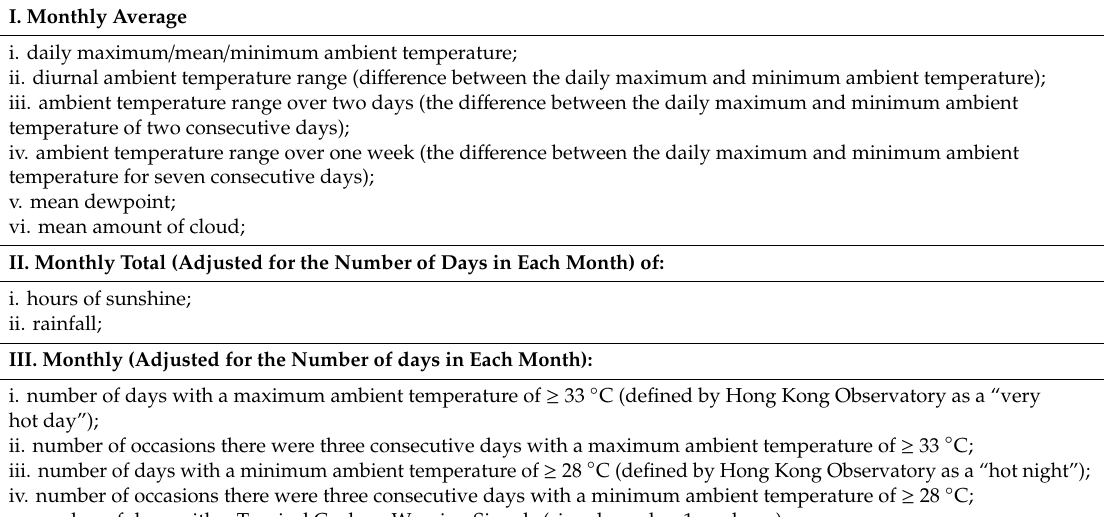
Table A1. Meteorological variables used in data analyses.